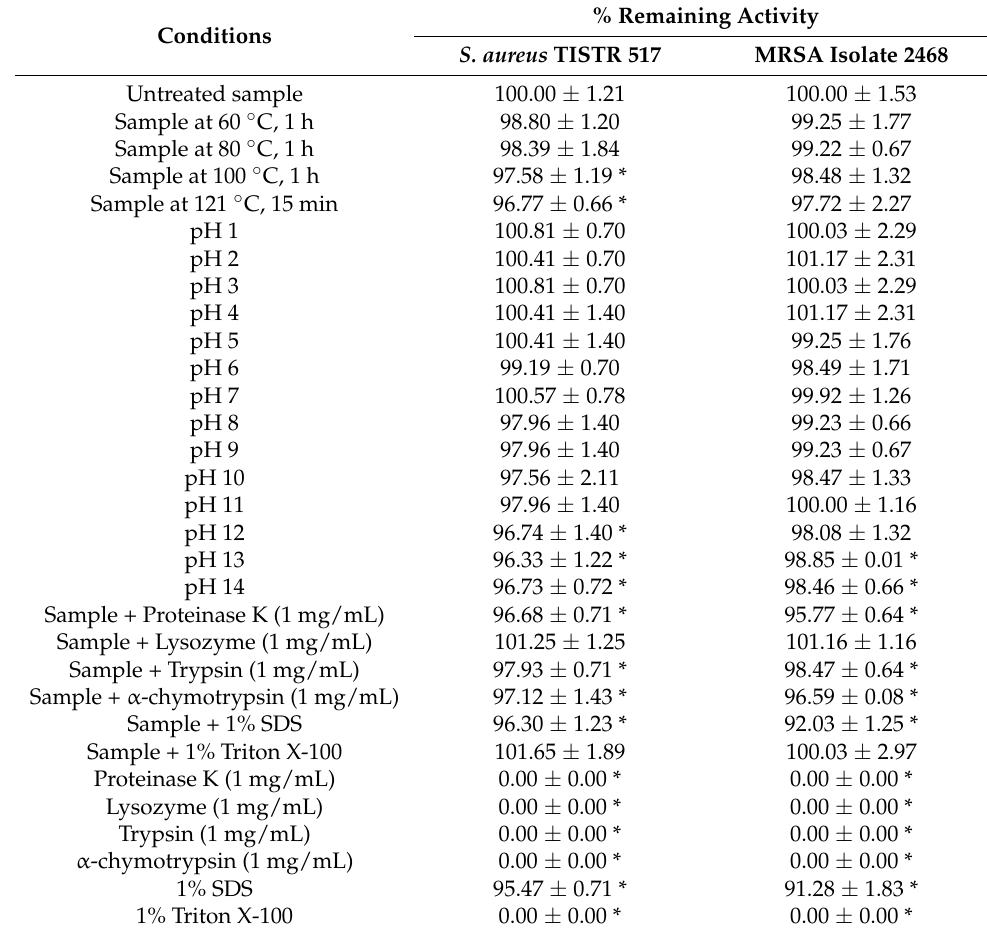
Table 5. Stability of pure substance against temperatures, proteolytic enzymes, surfactants, and pH. The result of the remaining activity when compared to the untreated sample was presented as mean ± SD from three replicate experiments.